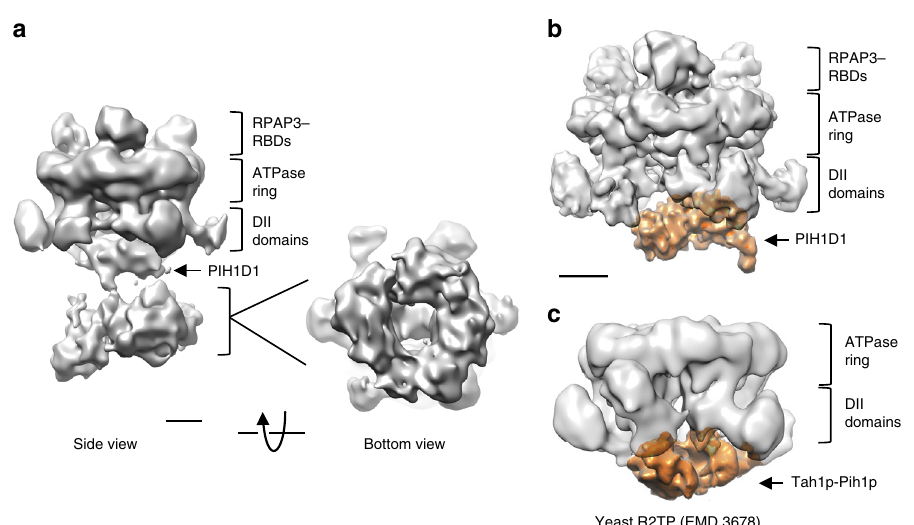
Fig. 7 Structural analysis of the fl exible region in R2TP. a Side and bottom view of the output 3D classi fi cation for a subset of particles with a more homogenous conformation for the fl exible regions. Scale bar, 2.5 nm. b Low-resolution structure of PIH1D1 region in R2TP complexes. Density for PIH1D1, highlighted in orange color. Scale bar, 2.5 nm. c One view of the structure of yeast R2TP (EMD 3678) 24 . Rvb1 – Rvb2 is shown in white transparency whilst the density for the yeast Tah1p – Pih1p complex is shown in orange color